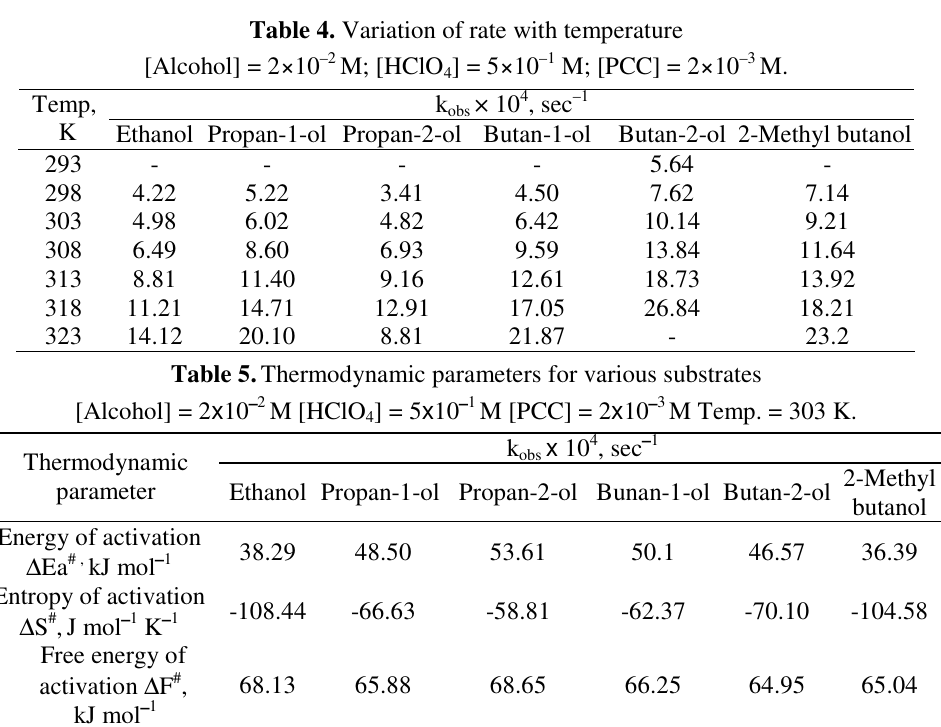
Table 4. Variation of rate with temperature